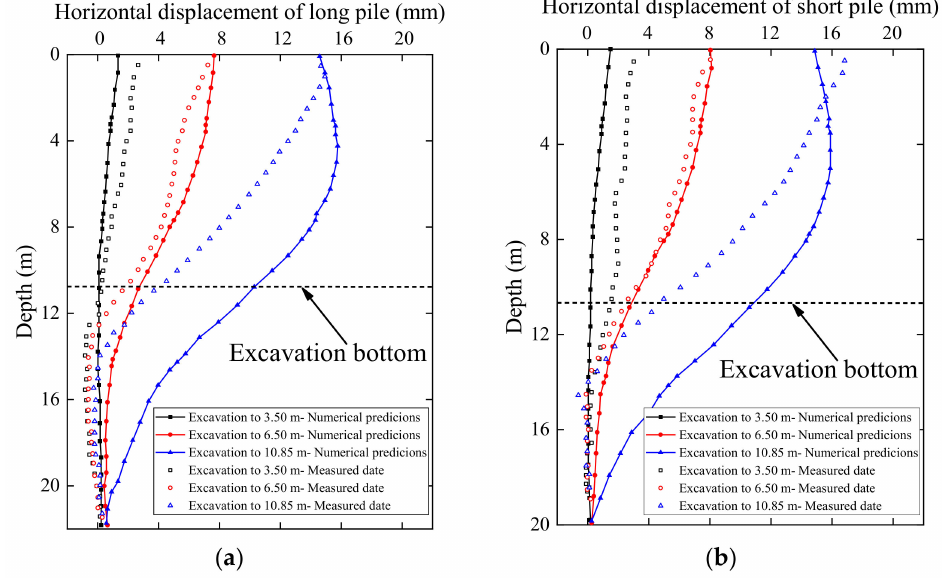
Figure 12. Comparison of measured horizontal displacement and numerical results (combination 1): ( a ) long pile; ( b ) short